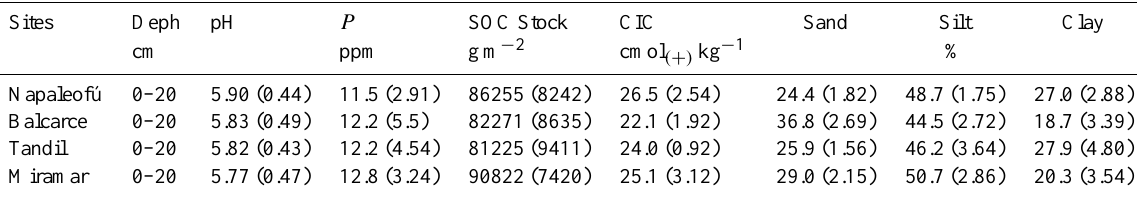
Table 1. Initial soil characteristics of the experiments: pH, P content, soil organic carbon (SOC) stock, cation exchange capacity (CEC), sand, silt and clay content, N = 3.